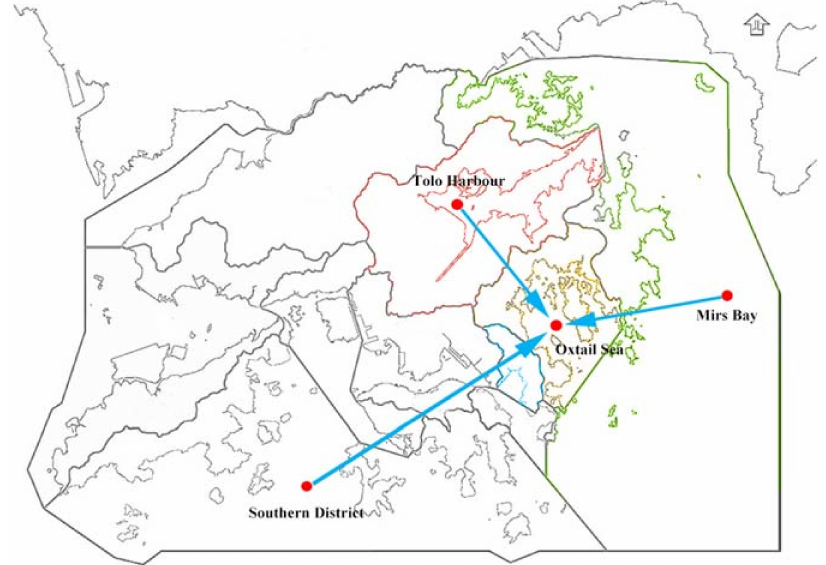
Figure 6. Spatial location of Oxtail Sea and nearby monitoring